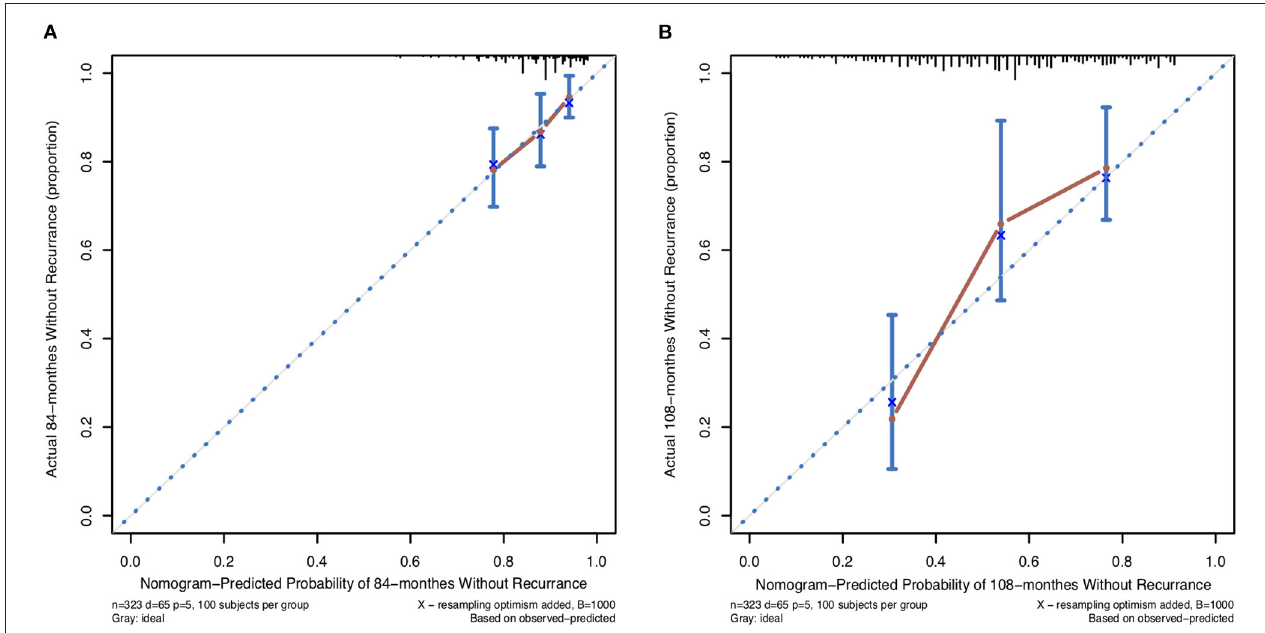
FIGURE 2 | The calibration curve for predicting patients without recurrence at (A) 84-month and (B) 108-month in the derivation cohort. Nomogram-predicted probability of overall without recurrence is plotted on the x-axis, actual overall without recurrence is plotted on the y-axis.